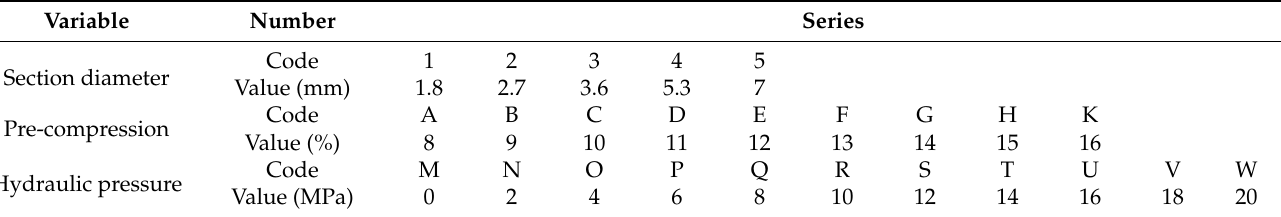
Table 1. Value and code of variable.